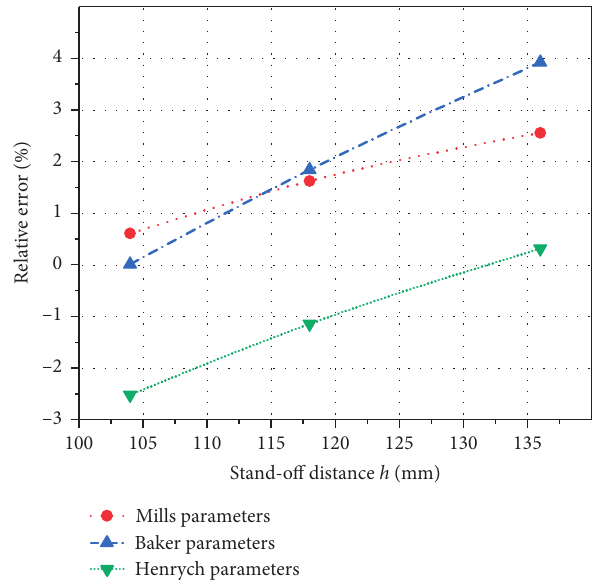
Figure 17: The relative error of K and the experimental